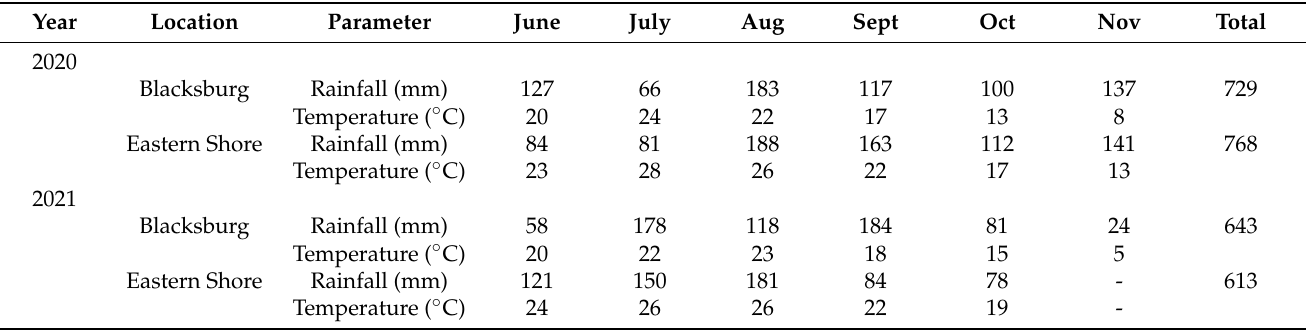
Table 3. Monthly rainfall (mm) and temperature ( ◦ C), between June and November at Blacksburg and Eastern Shore sites in 2020 and 2021.